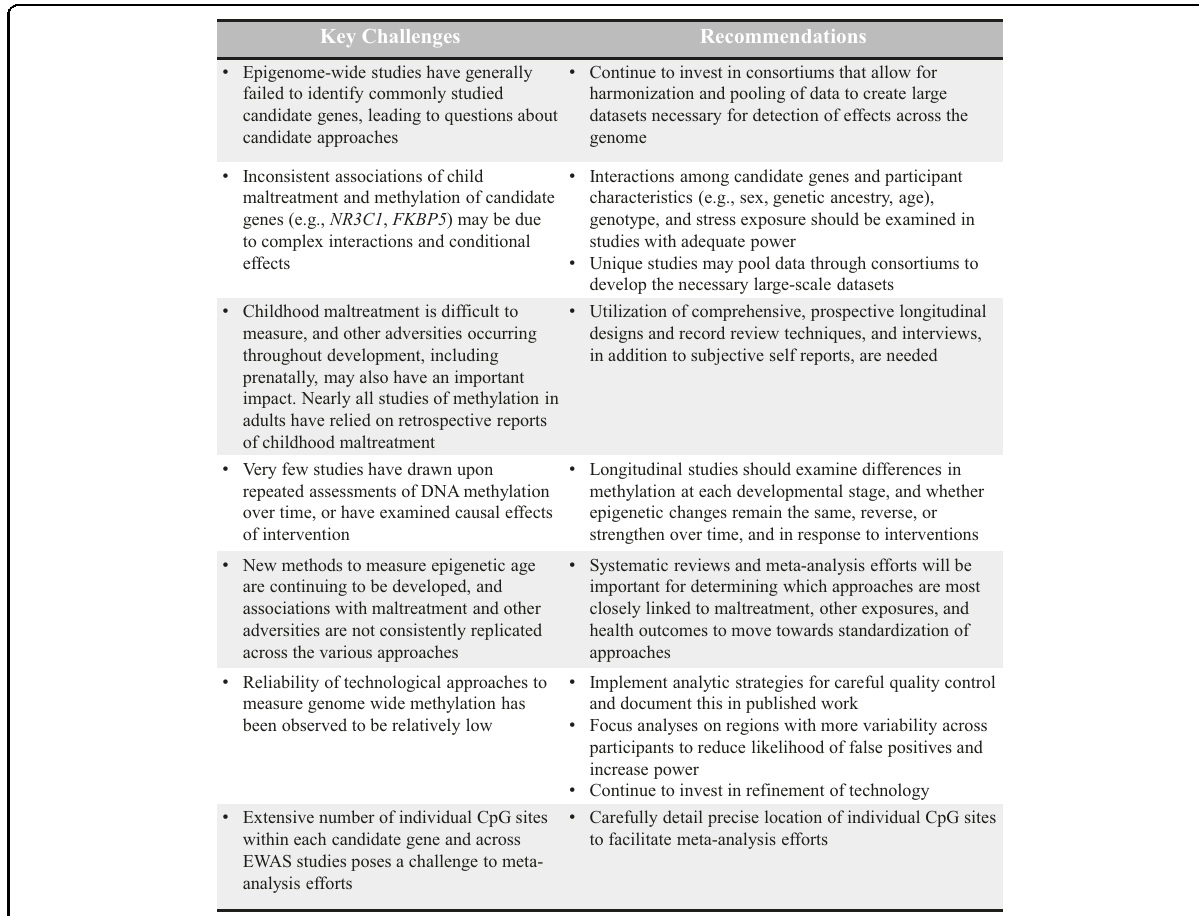
Fig. 3 Key challenges and recommendations. Note: Key challenges facing the fi eld and associated recommendations for future